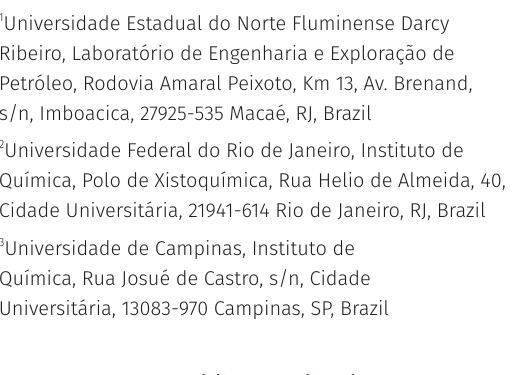
Figure S1. X-ray diffractograms of crystalline materials (bentonite, shale and sandstone). Figure S2. TGA thermograms of tested adsorbents. Figure S3. BET isotherms for adsorbents: (a) shale, (b) activated carbon, (c) bentonite, (d) silica gel, (e) sandstone, (f) wood powder. Figure S4. SEM images of adsorbents before the adsorption experiments: (a) silica gel, (b) wood powder, (c) activated carbon, (d) bentonite, (e) sandstone and (f) shale. Figure S5. SEM images of adsorbents with oil: (a) silica gel, (b) wood powder, (c) activated carbon, (d) bentonite, (e) sandstone and (f) shale. Figure S6. Mass chromatograms (RIC for the m/z 85 ion) of crude oils and filtered oils from C13 and C20